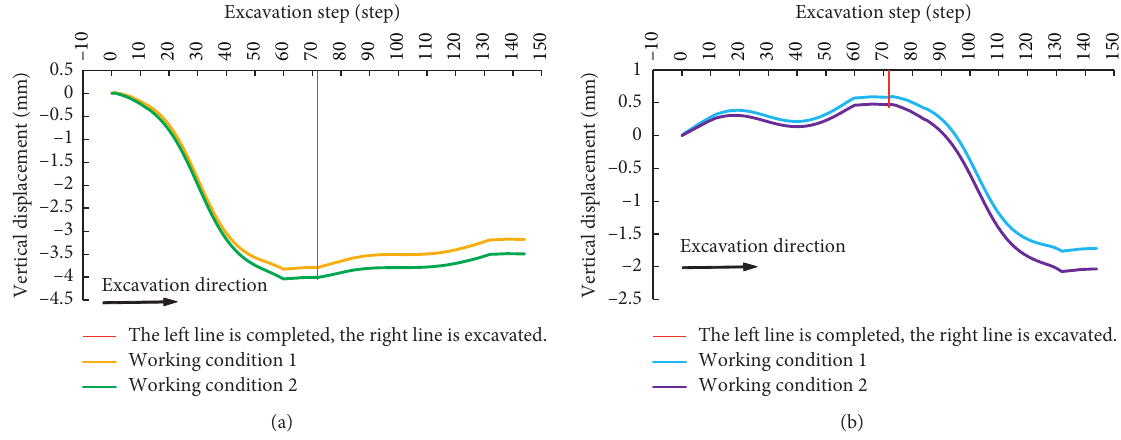
Figure 15: The vertical displacement curves of monitoring points (a) R30-LL-4 and (b) R30-RR-10 during